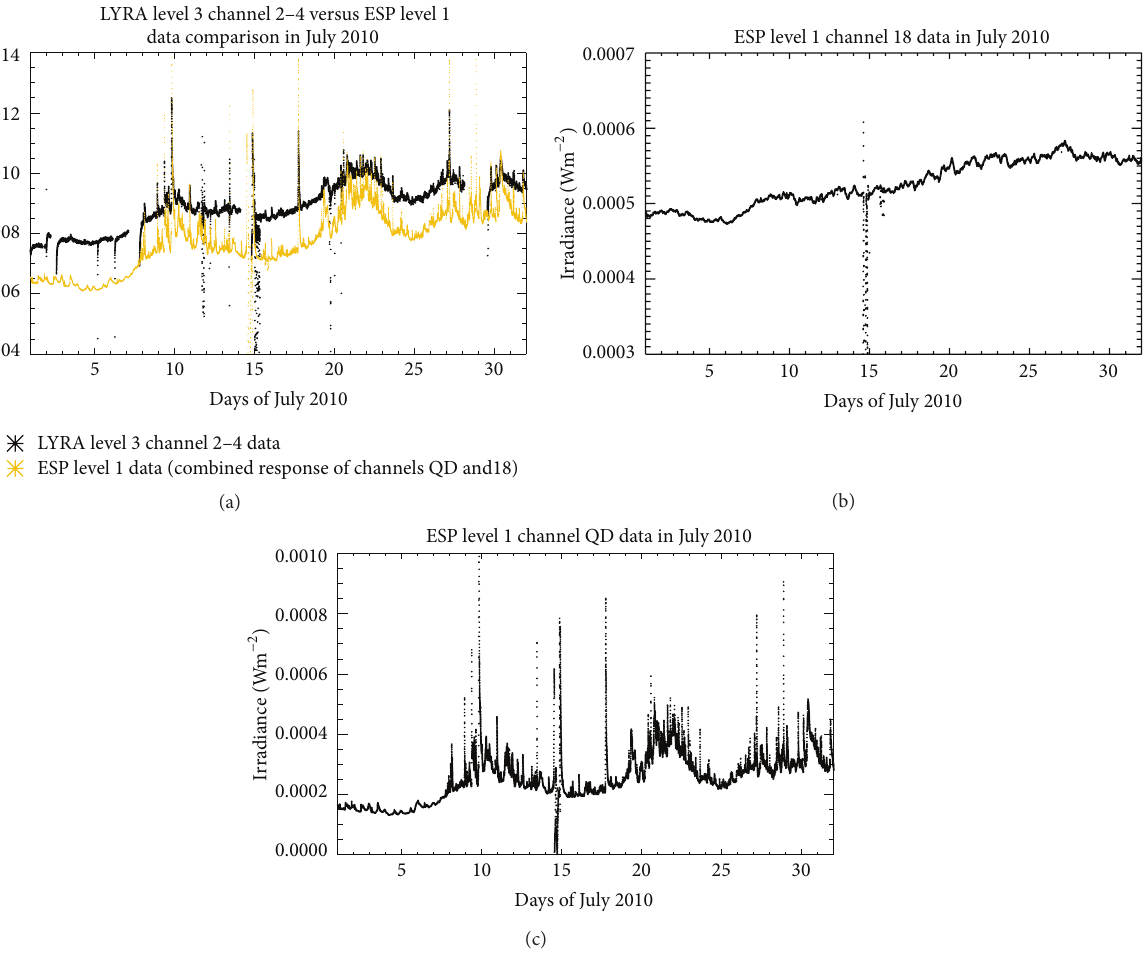
Figure 6: LYRA level 3 channel 2–4 and ESP level 1 data variations (at combined responses of the channels QD and 18, and separately) in July 2010. The downward spikes in the ESP data on July 14, 2010 are due to the calibration maneuvers of